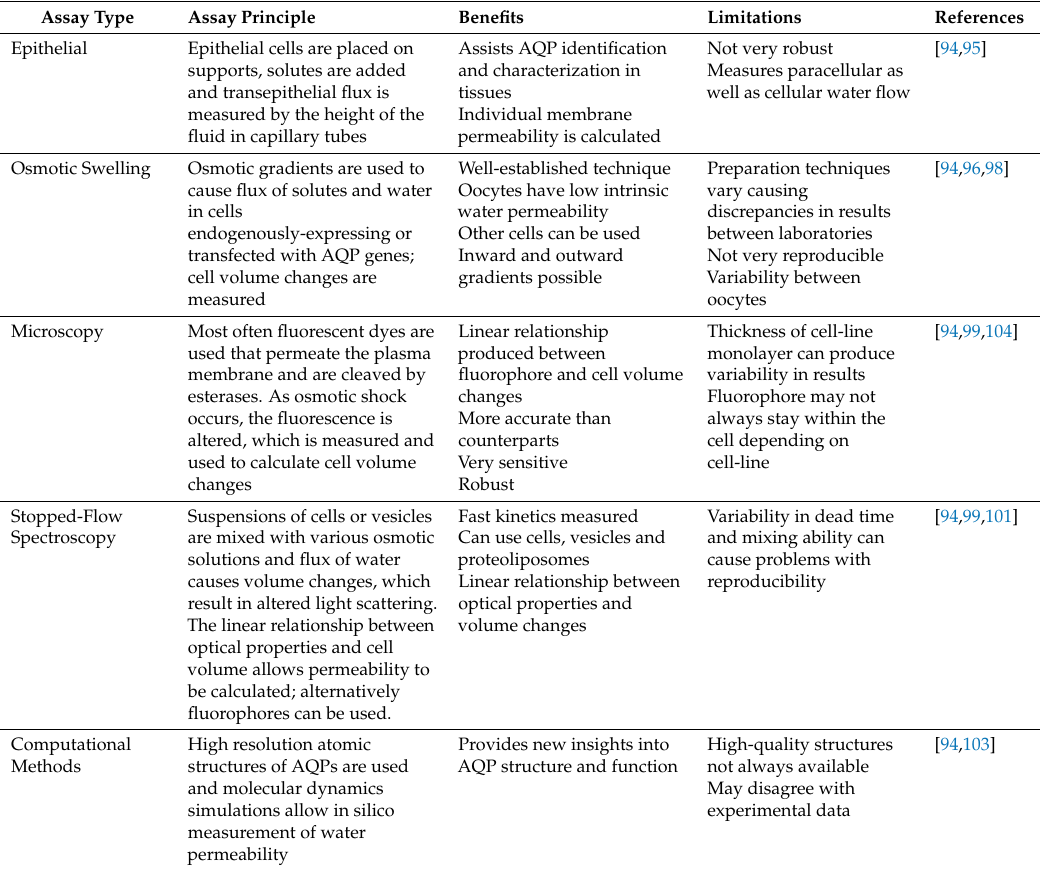
Table 2. Various assay methods used in the measurement of AQP function and the validation of AQP inhibitors. Their benefits and limitations are shown.